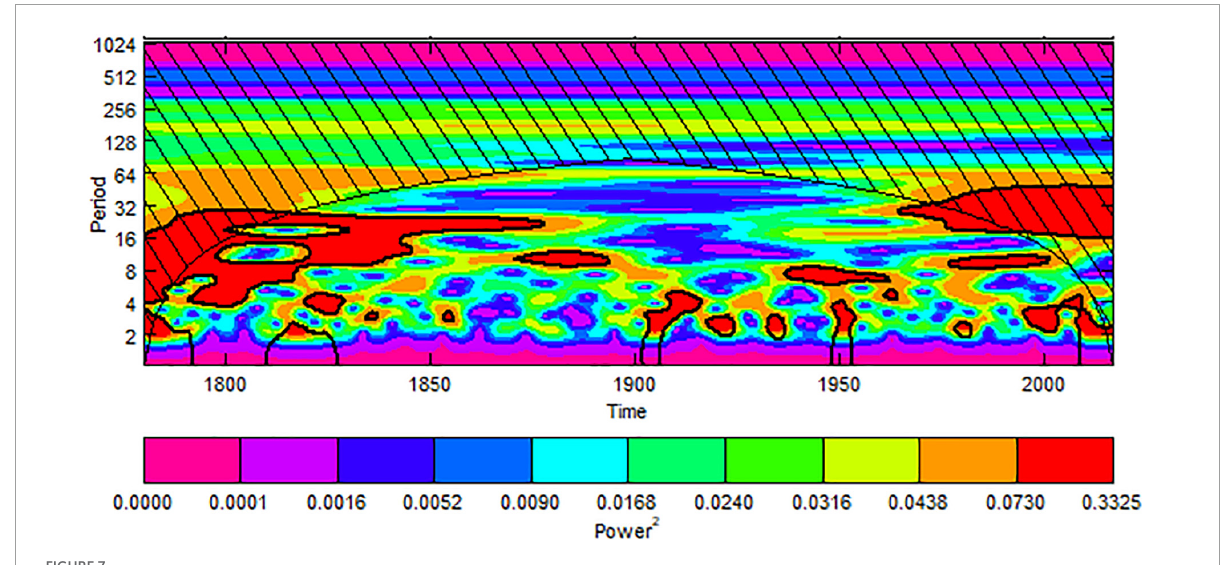
FIGURE7 Morlet wavelet spectrum with a high edge effect and a red-noise background at 95% confidence level (black lines/contours) for reconstructed PPT JJA